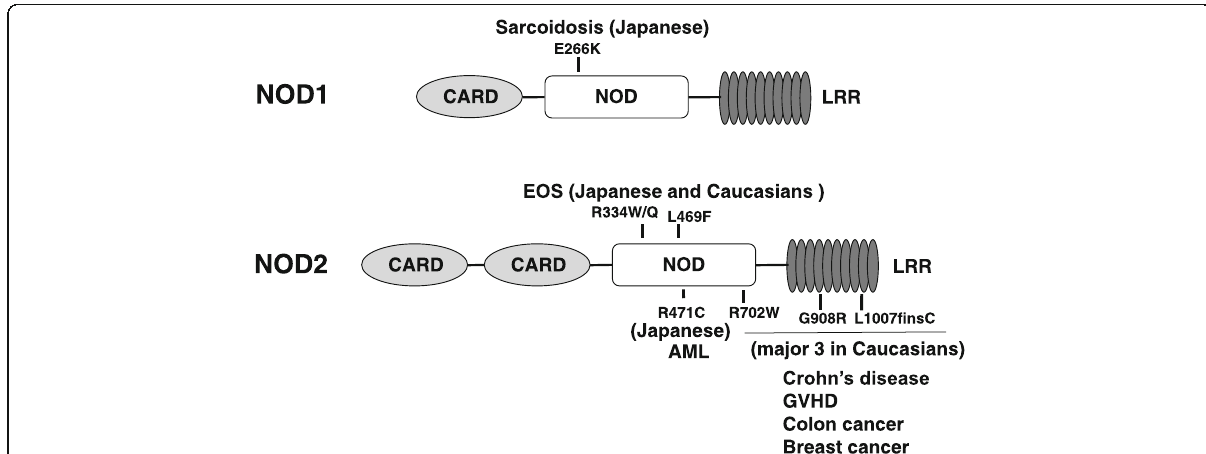
Fig. 2 Mutations in NLR that cause immune-related diseases. NOD1 variant E266K associated with sarcoidosis was found in Japanese population. Three mutations in NOD domain of NOD2 (R334W, R334Q, and L469F) exist both in Blau syndrome in Caucasians and EOS in Japanese cohort. NOD2 SNPs near or within the LRRs of Nod2 (R702W, G908R, L1007insC) are associated with the development of CD in Caucasians that does not exist in Japanese